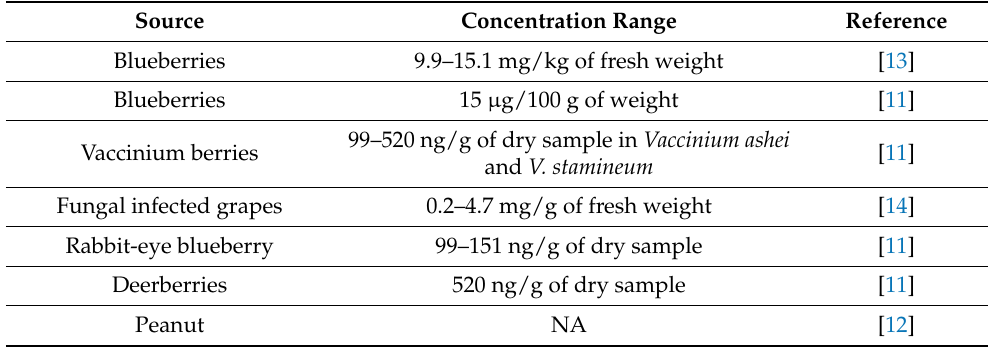
Table 1. Potential Sources of